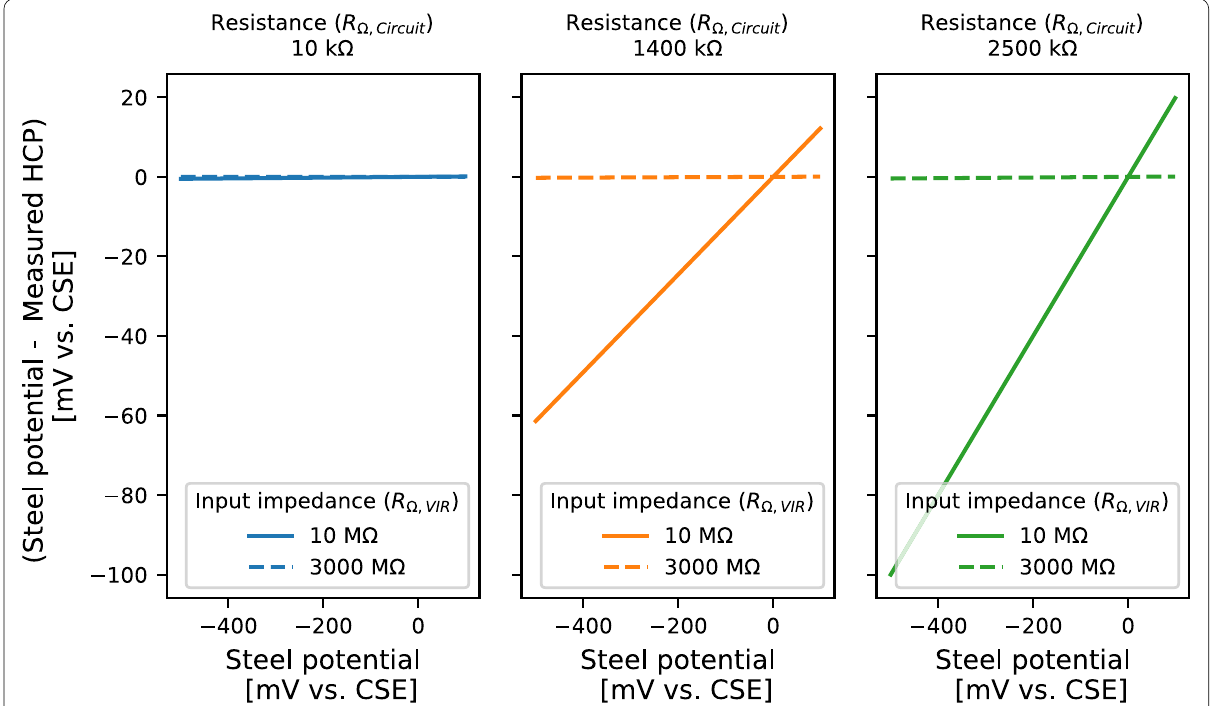
Fig. 18 Evaluation of eq. (1) for several parameter combinations of the input impedance of the voltmeter (10 MΩ. for the solid line and 3000 MΩ for the dashed line) and different resistance of the electrical circuit (10 kΩ, 1400 kΩ, 2500